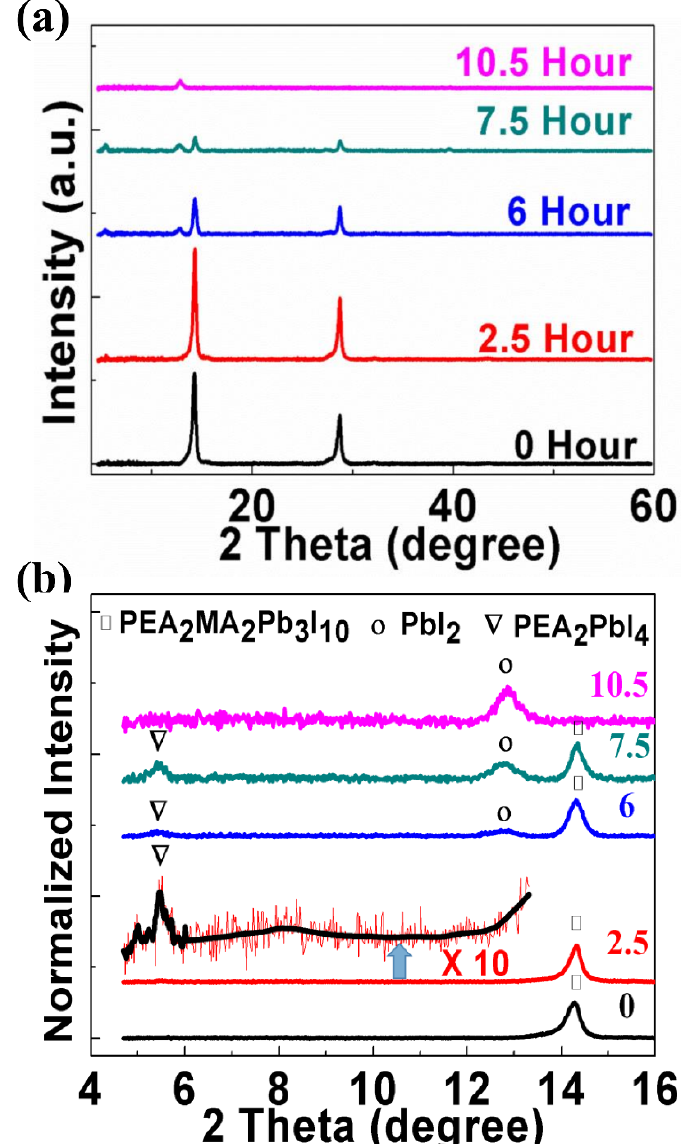
Figure 7. ( a ) The X-ray diffraction (XRD) patterns of PEA 2 MA 2 Pb 3 I 10 from 4–60 degrees, ( b ) Normalized XRD intensity from 4–16 degrees under continuous white light illumination at 300 mW/cm 2 in an ambient environment. Part of the pattern after 2.5 h of illumination is enlarged 10-fold (the red curve is data, the black curve is for guiding the eye) in order to clearly show the peak of the n = 1 and n = 2 materials.